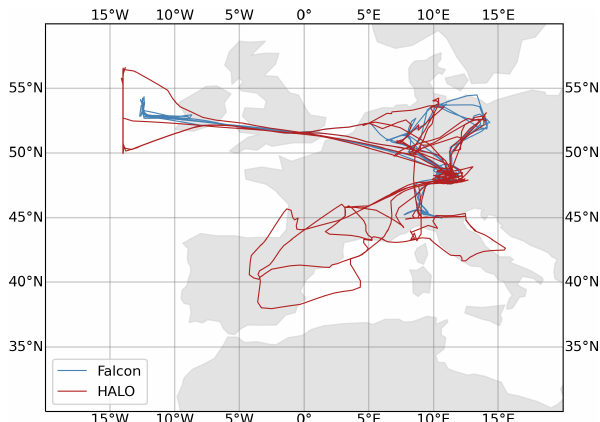
Figure 1. Tracks of conducted flights during the BLUESKY cam- paign (16 May to 9 June 2020). Colors denote the aircraft: Falcon (blue) and HALO